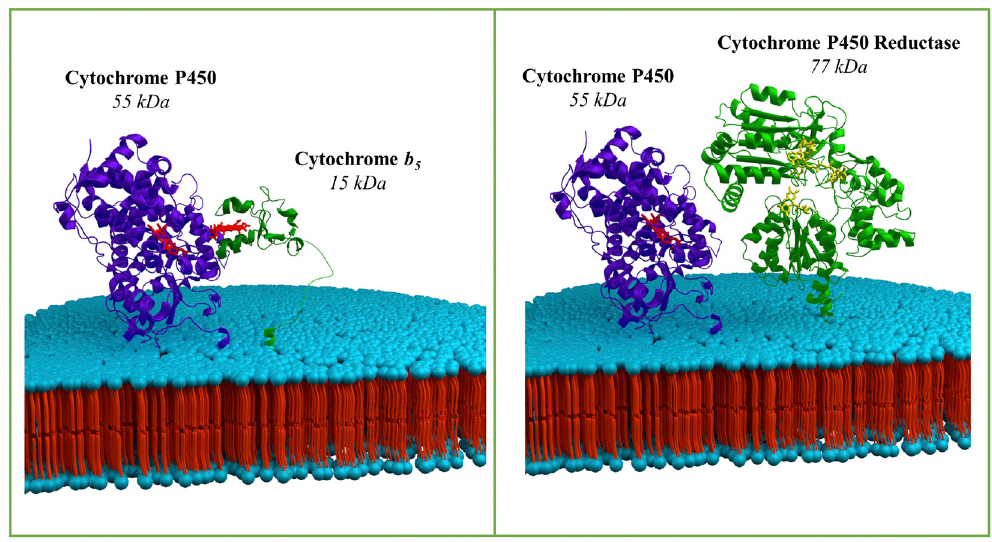
Figure 2. Model structures of cytochrome P450 with cytochrome b (left) and cytochrome P450 with cytochrome P450 5 NADPH-reductase (right) in a lipid bilayer. The models were constructed from the crystallographic or solution-state nuclear magnetic resonance (NMR) structures of the soluble domains of the proteins. The structure, dynamics, and topology of the invisible transmembrane domains of the full-length cytochrome proteins have been determined for the first time by static solid-state NMR experiments on magnetically aligned bicelles. These studies reported that the helical structures of the transmembrane domains are significantly tilted away from the lipid bilayer normal and undergo motion in the millisecond (or slower) timescale that is far slower than that of the residues in the soluble domain 17,18,45